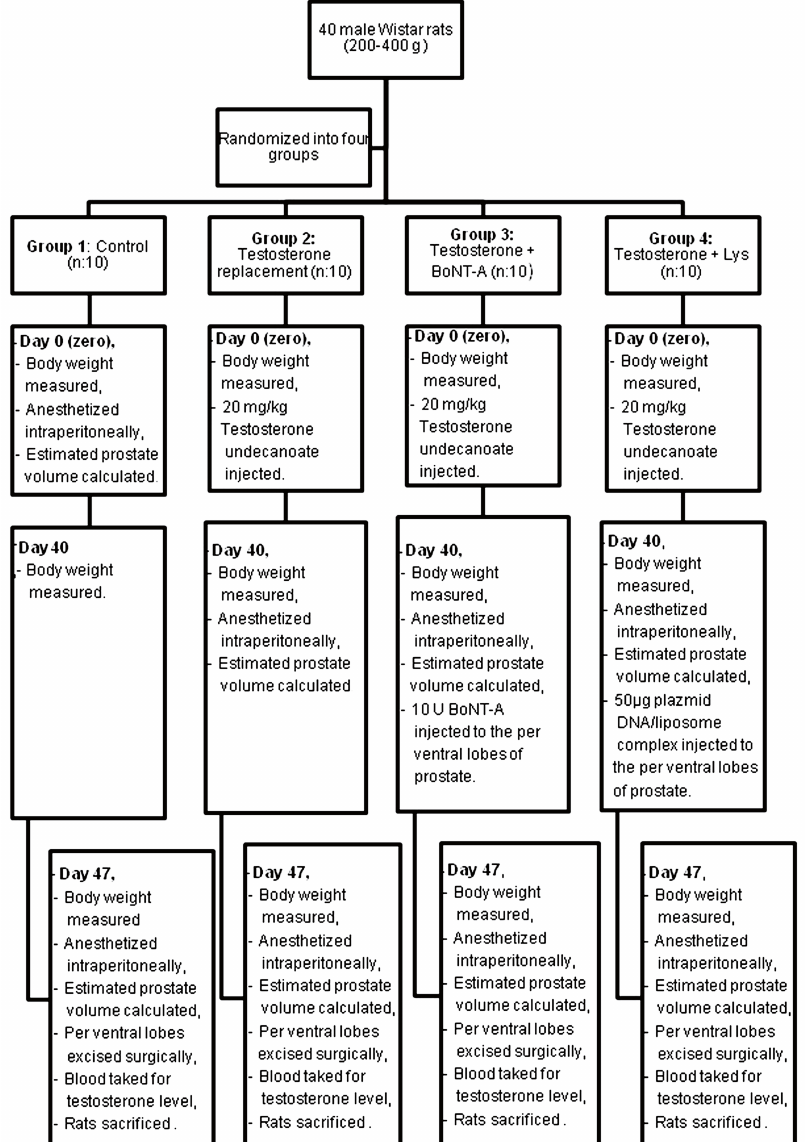
figure 1 - Experimental